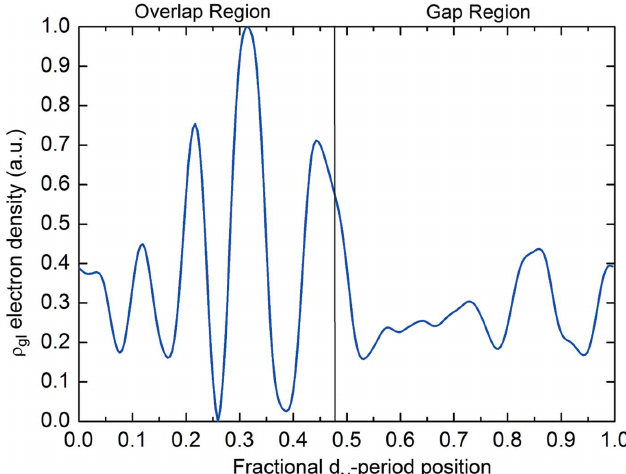
Figure 3 Electron density profile derived by the Fourier difference phasing carried out on the SAXS patterns in Fig. 2( a